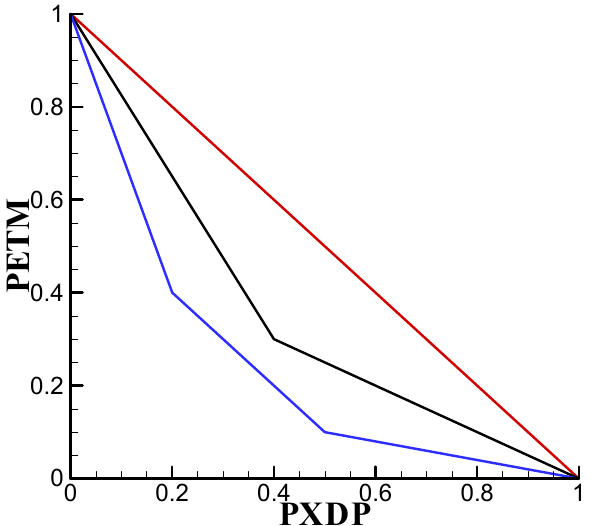
Figure 6. The reference relationship (black line) and two postulated relationships (red and blue lines) used in the ETS